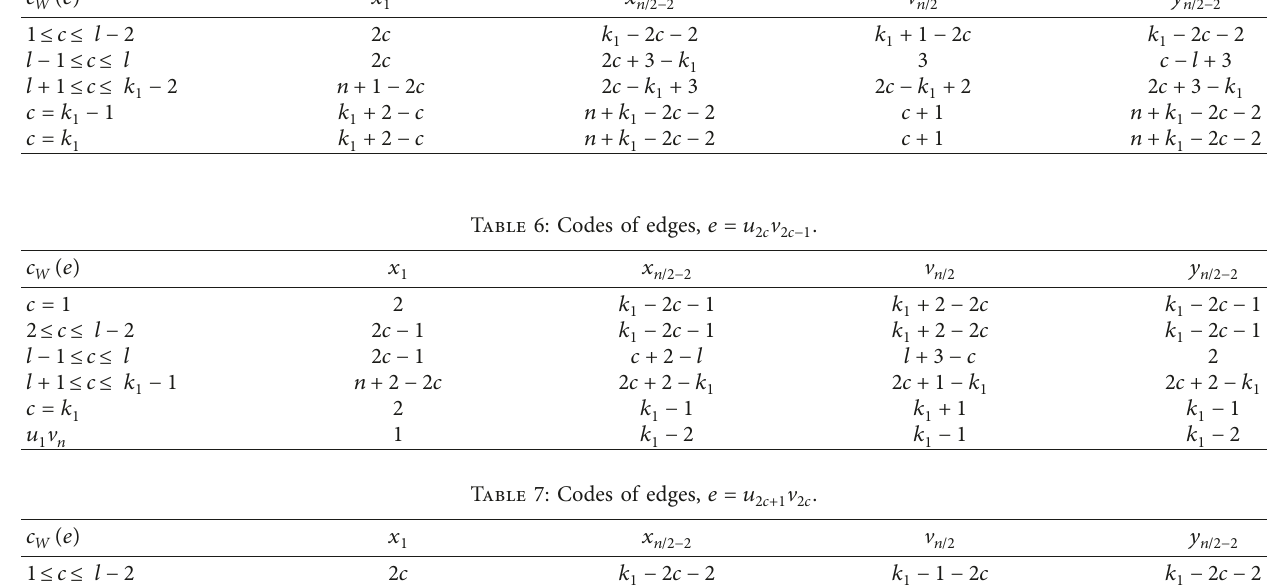
Table 5: Codes of edges, e � u